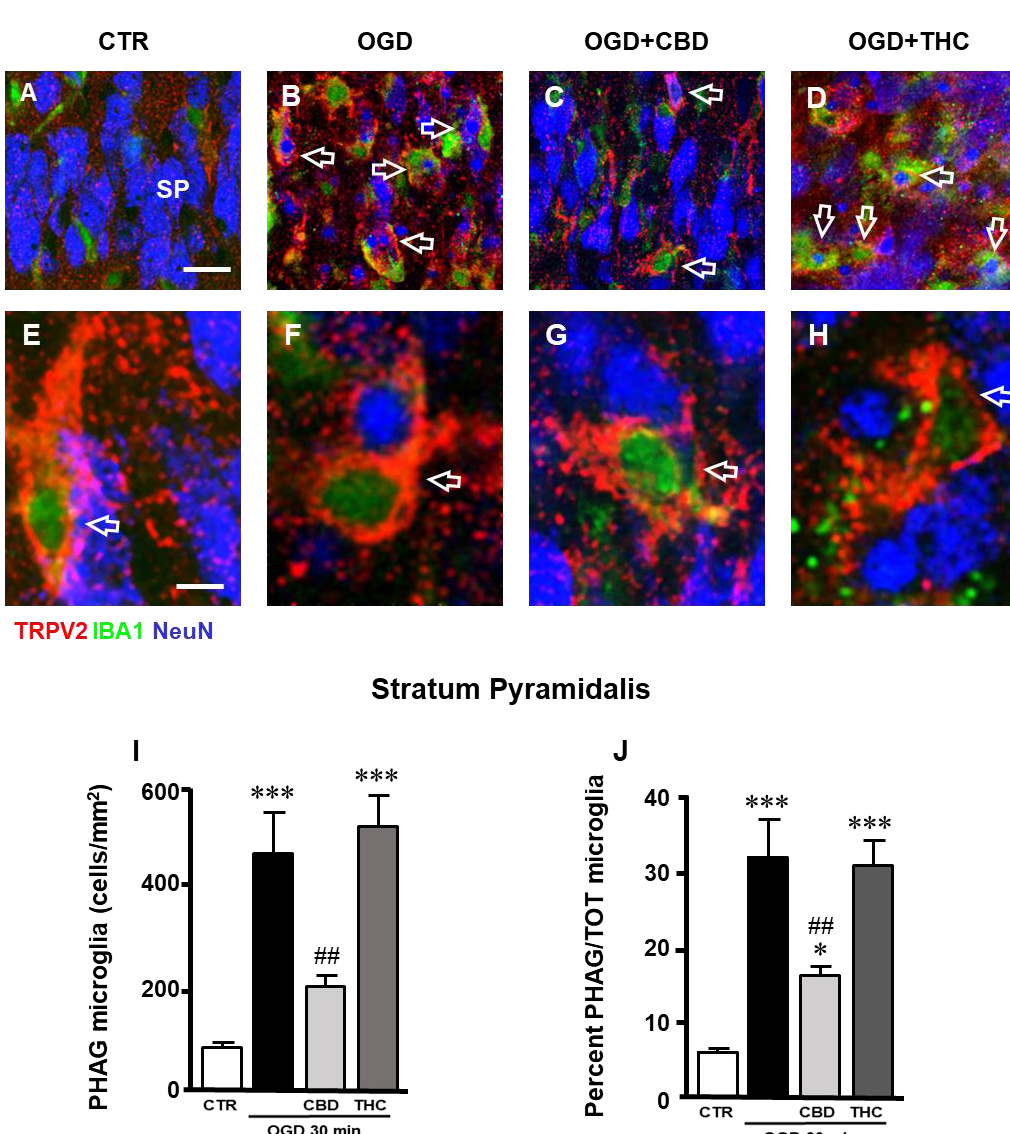
Figure 3. ( A – D ) Representative confocal images of immunostaining of TRPV2 channels (TRPV2, red), total microglia (IBA1, green), and neurons (NeuN, blue) in CA1 SP of CTR ( A ), OGD ( B ), OGD + CBD ( C ), and OGD + THC ( D ) slices. Images are z-projections of two confocal z-scans captured with a 63 × objective (total thickness: 0.6 µ m). Scale bar: 20 µ m. Twenty-four hours after OGD, the expression of TRPV2 channel in CA1 SP was mainly localized on activated microglia cells that showed a green cellular body and yellow-orange cytoplasm and projections (open arrows in panel B ) that phagocytose neurons or neuronal fragments (blue cells and cellular fragments within the microglia cell body in panel B). From a qualitative analysis, it appears that this effect was prevented by CBD (open arrows in panel C), but not by THC (open arrows in panel D). ( E – H ) Images are z-projections of five confocal z-scans captured with a 63× objective (total thickness: 1.5 µm). Scale bar: 10 µ m. These enlargements clearly show the expression of the TRPV2 channel in activated microglia (open arrows in panels E – H). ( I ) Quantitative analyses of phagocytic microglia density in CA1 SP of CTR (n = 8), OGD (n = 8), OGD + CBD (n = 8), and OGD + THC slices (n = 7). Statistical analysis: one-way ANOVA p < 0.0001; Newman – Keuls post hoc test *** p < 0.001 vs. CTR, ## p < 0.01 vs. OGD. ( J ) Quantitative analyses of percentage of phagocytic microglia out of the total microglia in CA1 SP of CTR (n = 8), OGD (n = 8), OGD + CBD (n = 8), and OGD + THC slices (n = 7). Statistical analysis: one-way ANOVA p < 0.0001; Newman – Keuls post hoc test *** p < 0.001 and * p < 0.05 vs. CTR, ## p < 0.05 vs. OGD.